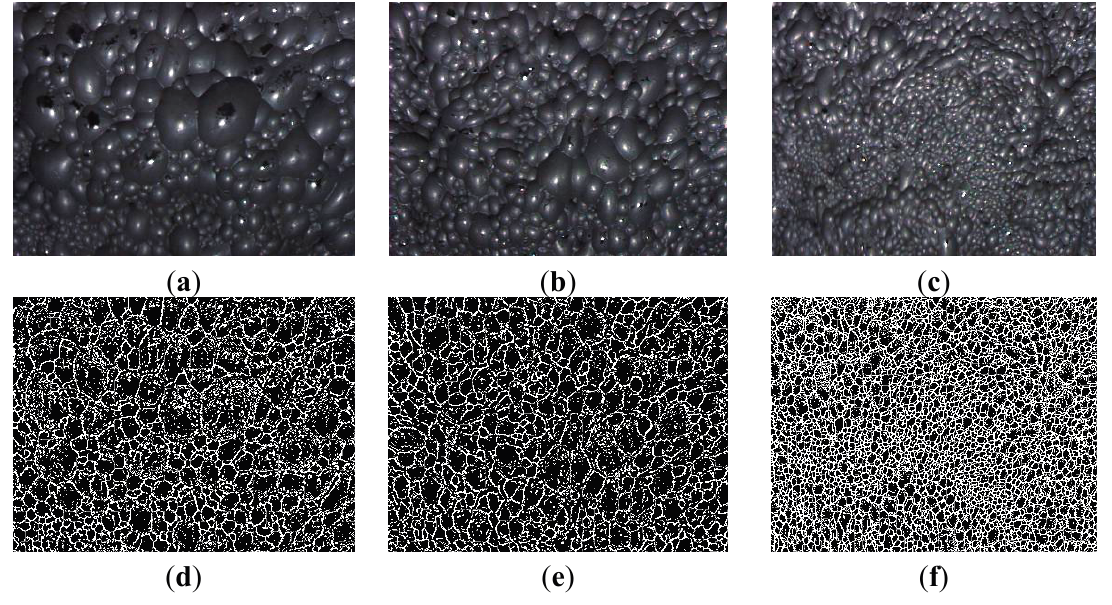
Figure 6. Edge detection results based on the proposed algorithm. ( a – c ) represent the original images of large, middle and small bubbles separately; ( d – f ) are the edge detection results corresponding to the images in (a), (b) and (c),